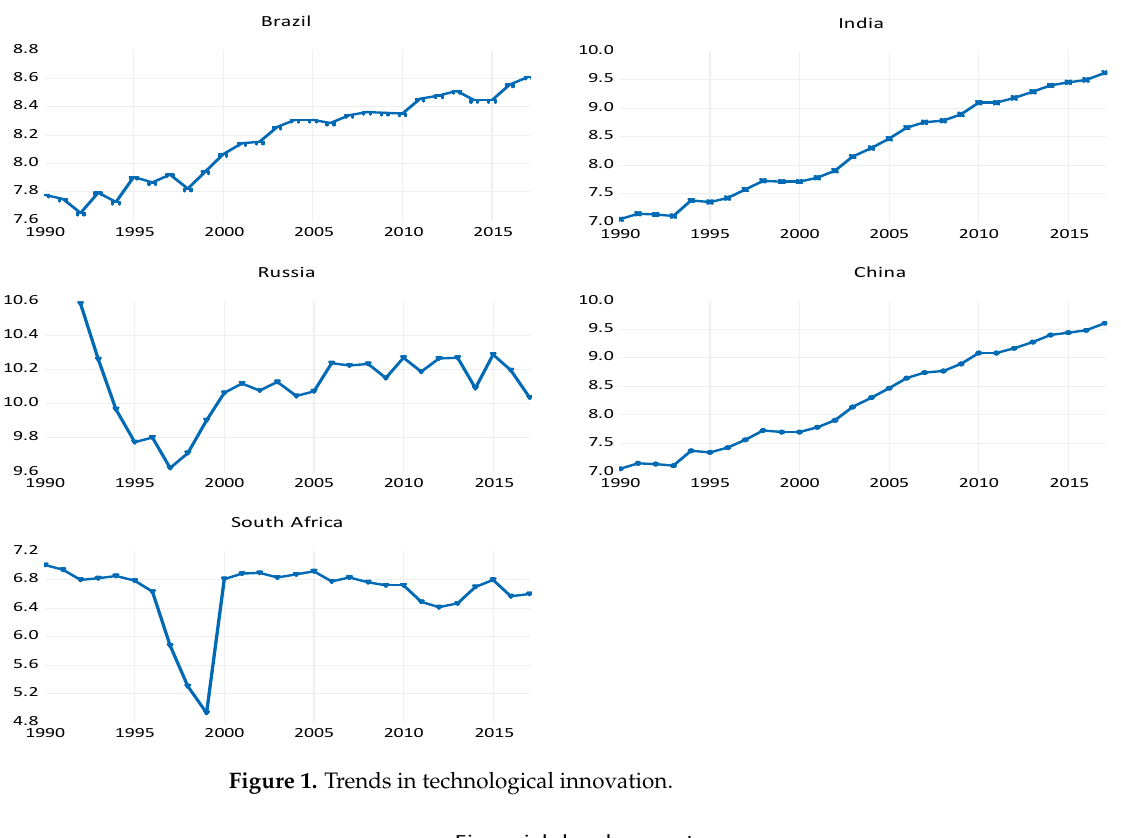
Figure 1. Trends in technological innovation.